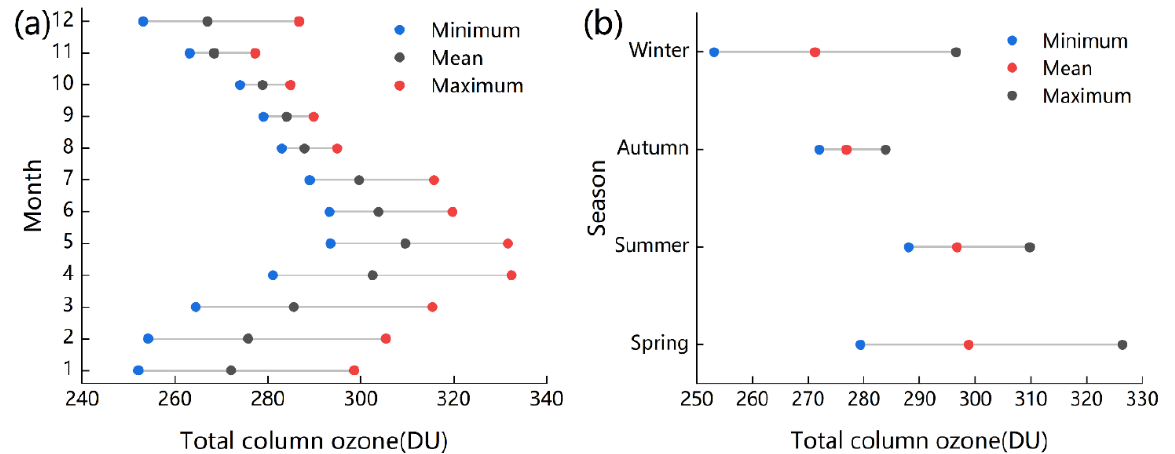
Figure A3. Lollipop Diagram of Monthly ( a ) and Seasonal ( b ) Spatial Distributions of the TCO over the Yangtze River Delta Urban Agglomerations during 2000 – 2019.